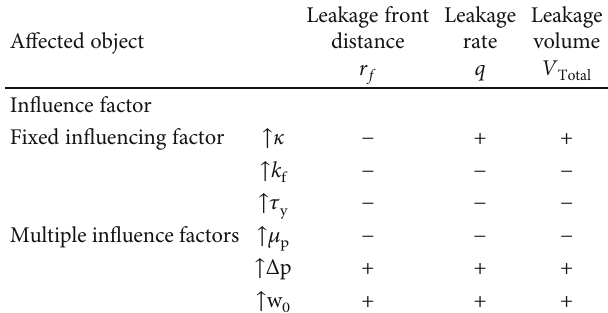
Figure 12: Leakage volume under di ff erent formation permeability and fracture normal sti ff Table 2: In fl uence of multiple factors.